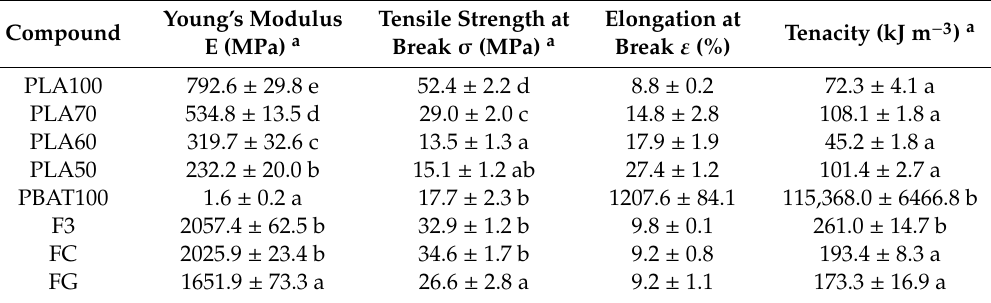
Table 6. Tensile properties of test specimens for homopolymers, their blends, and the fibers. Young’s Modulus Tensile Strength at Elongation at Tenacity (kJ m − 3 ) a Compound E (MPa) a Break σ (MPa) a Break ε (%) PLA100 792.6 ± 29.8